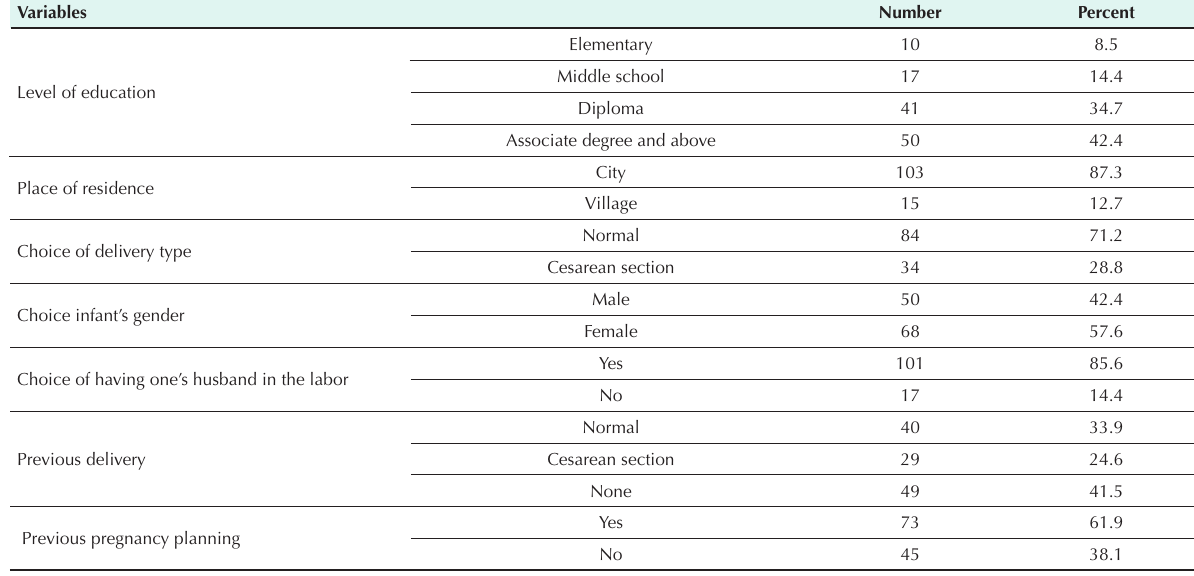
Table 1. Frequency Distribution Table for Demographic Variables Variables